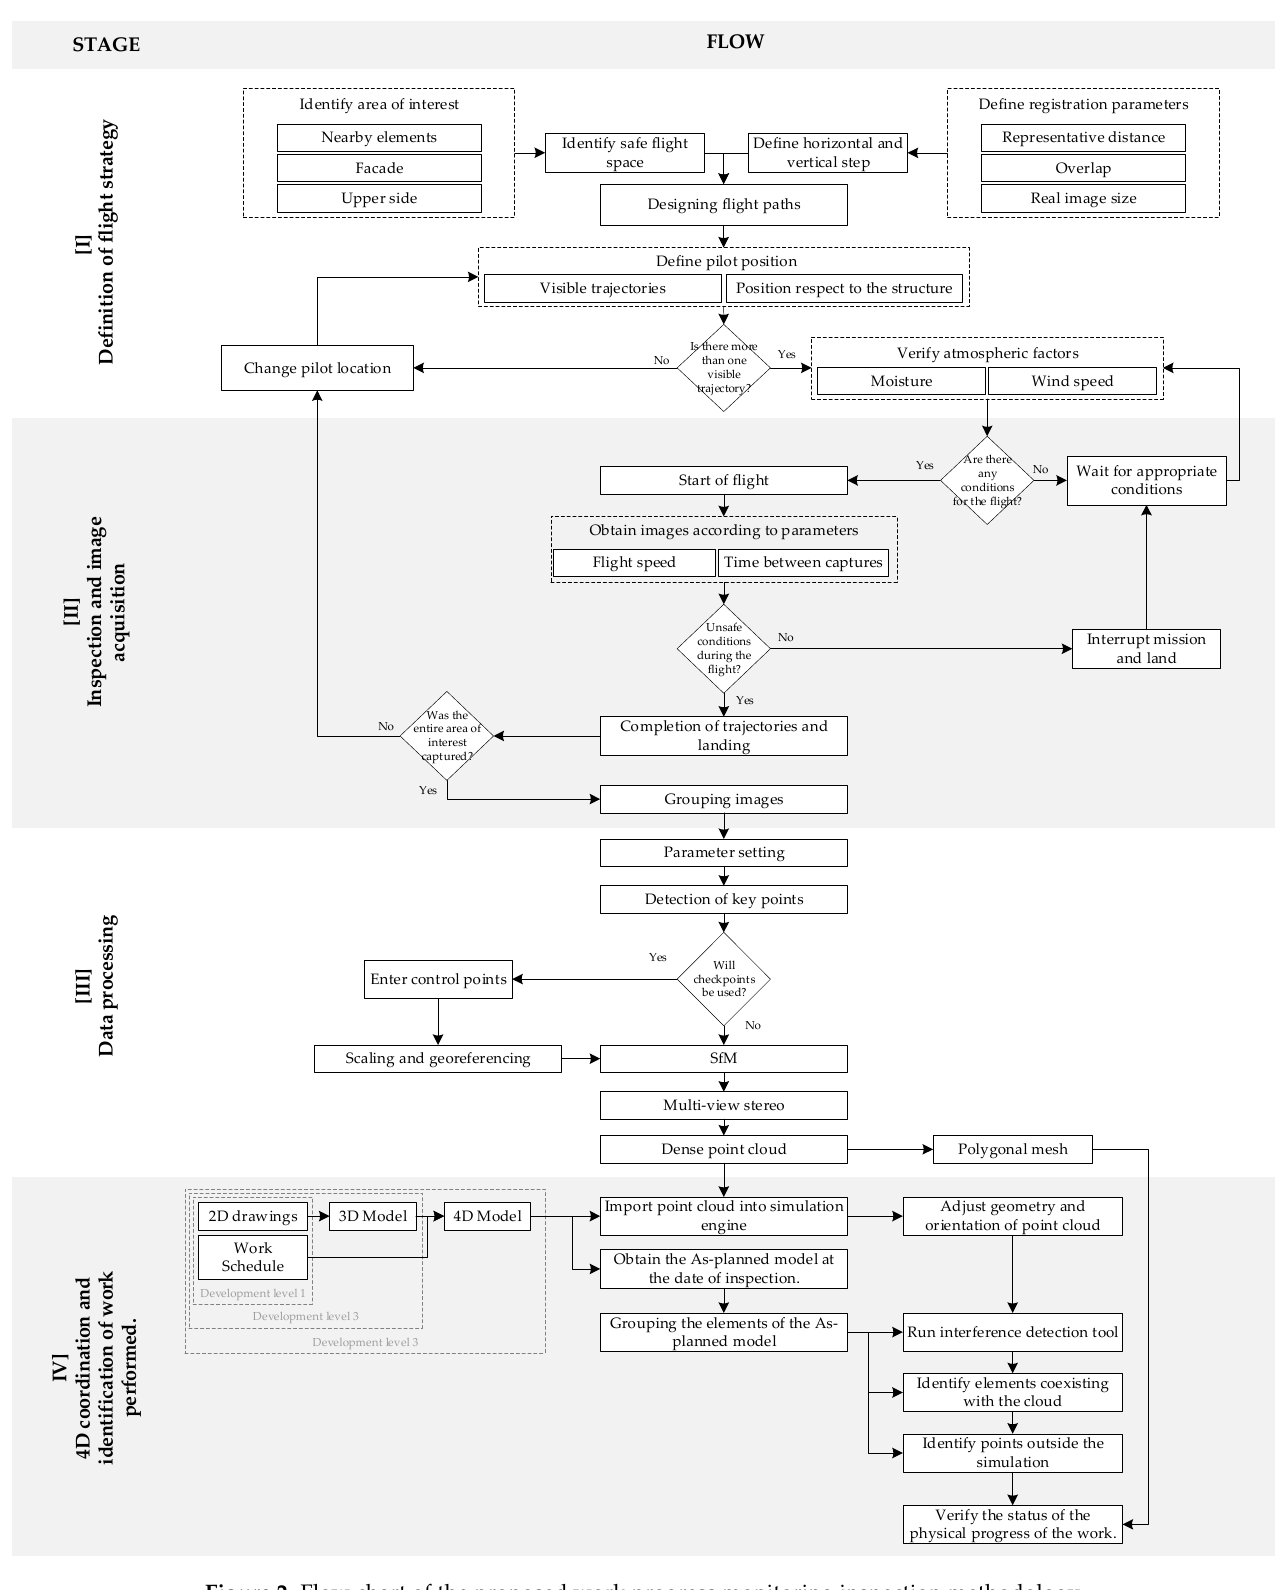
Figure 2. Flow chart of the proposed work progress monitoring inspection methodology.